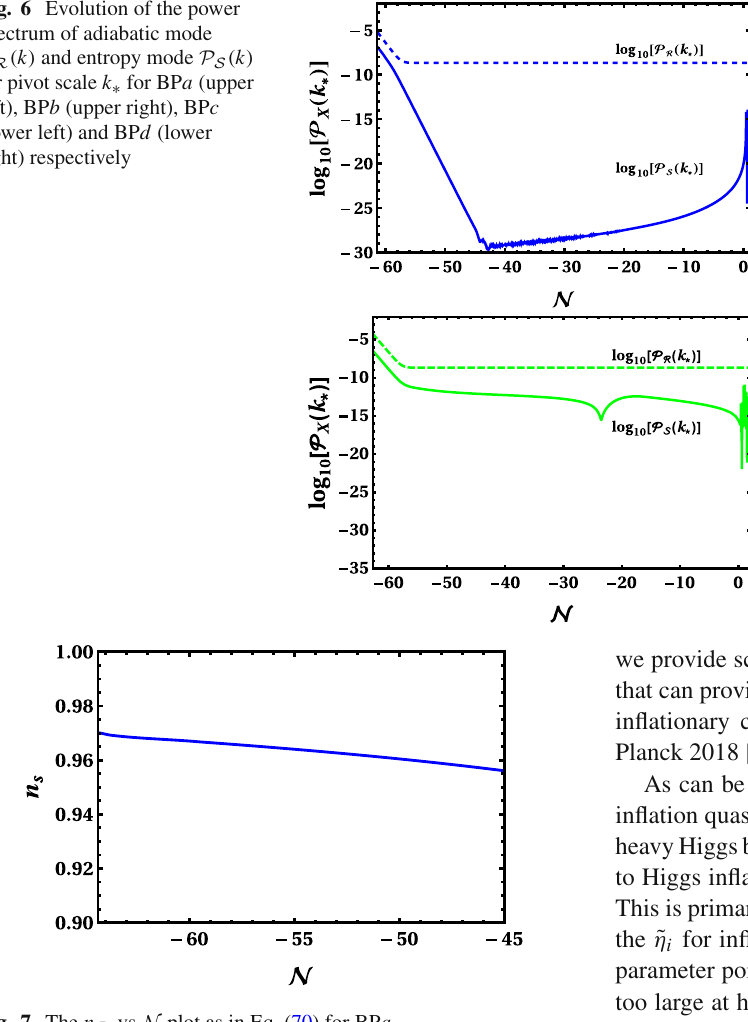
Fig. 7 The n R vs N plot as in Eq. (70) for BP a